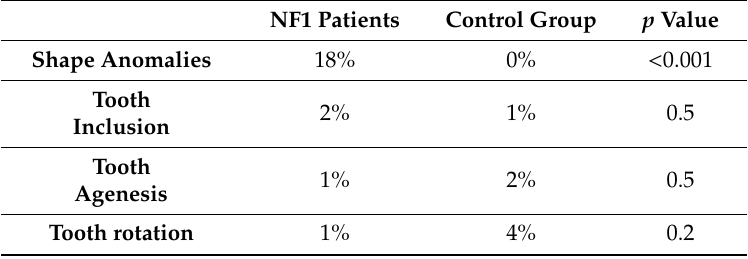
Table 4. Statistical comparisons between single dental